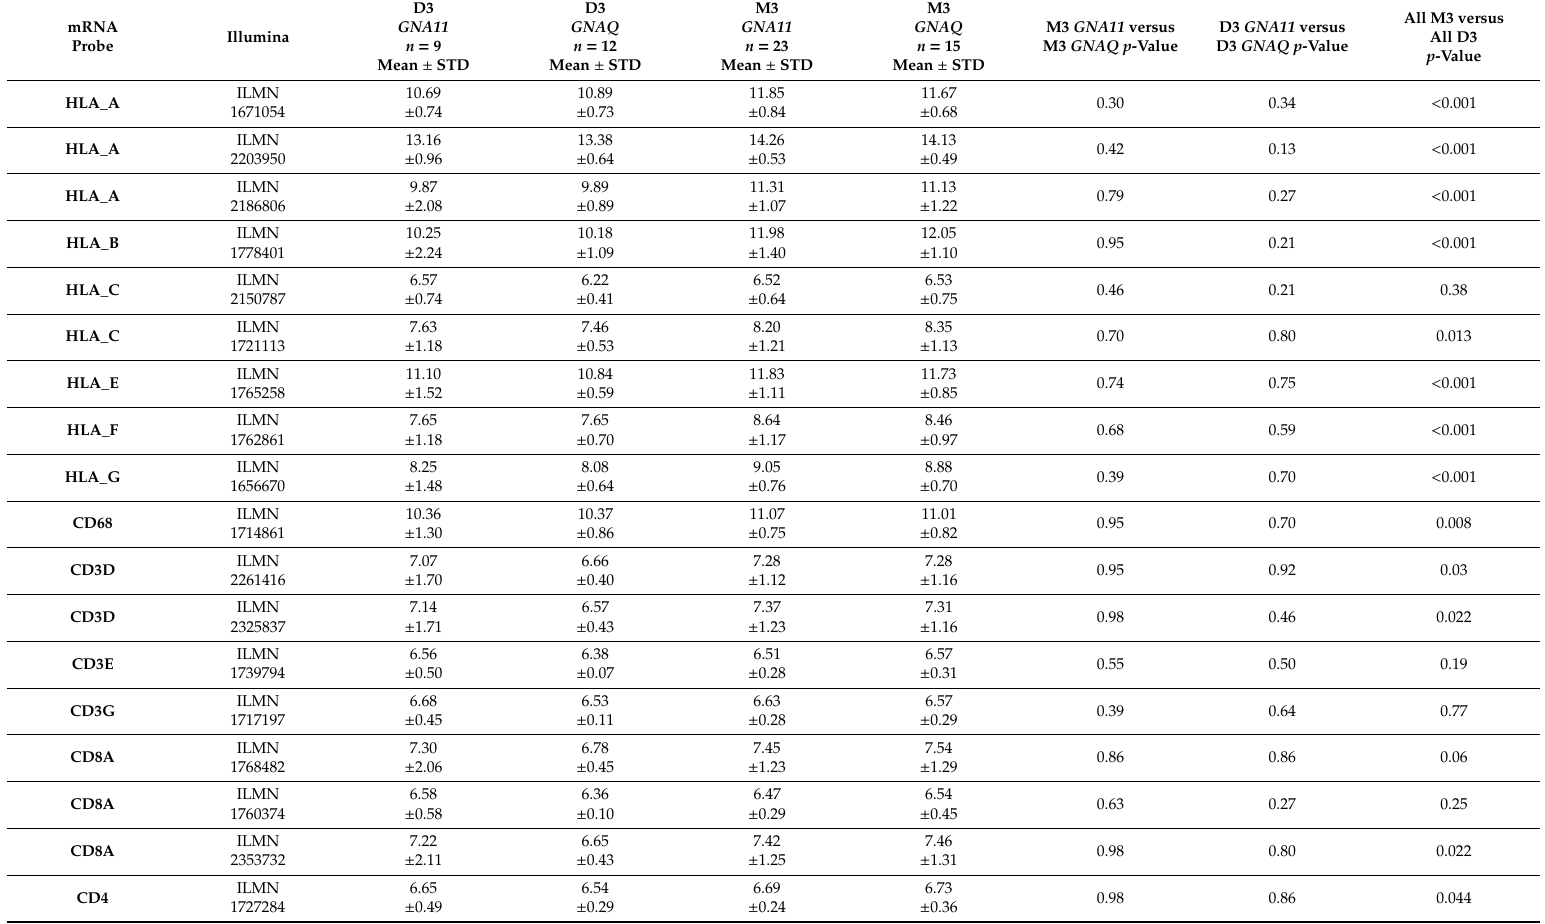
Table 3. Mean expression of mRNA expression of HLA Class I antigens and infiltrating immune cells in relation to the GNA11 or GNAQ mutation. p -values were calculated using the Wilcoxon-Rank sum test. STD = standard